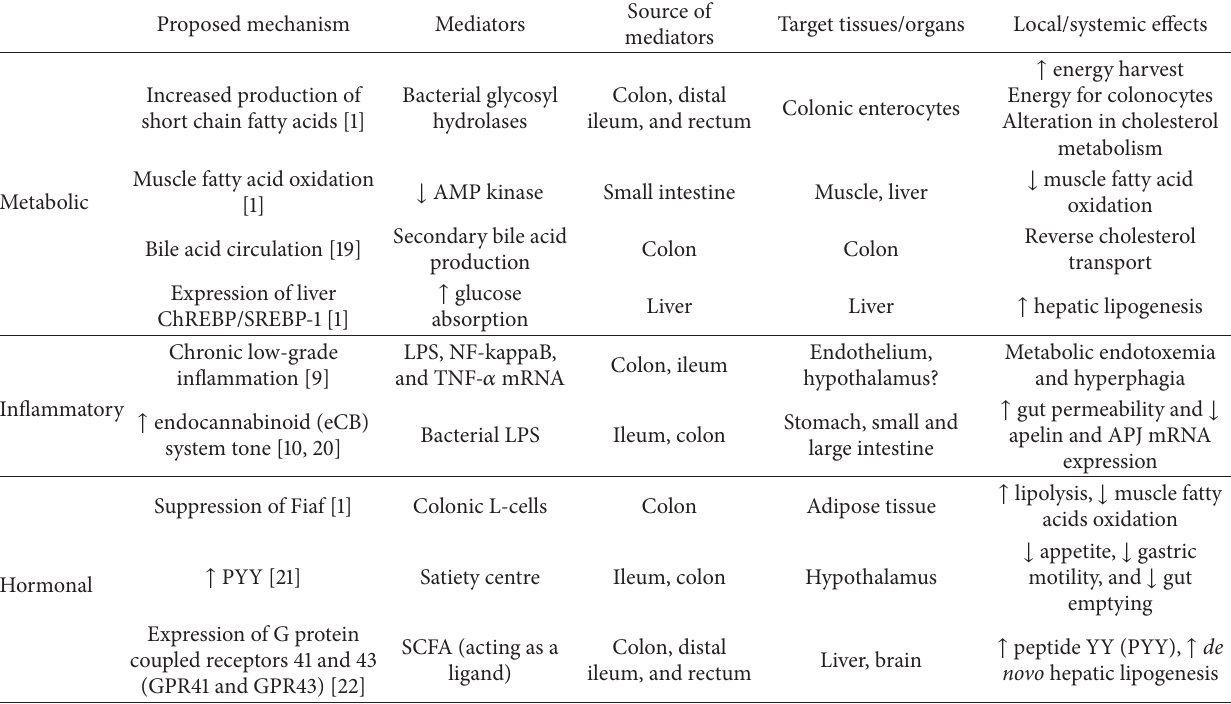
Table 1: Suggested mechanisms for the role of gut microbiota in the aetiology of